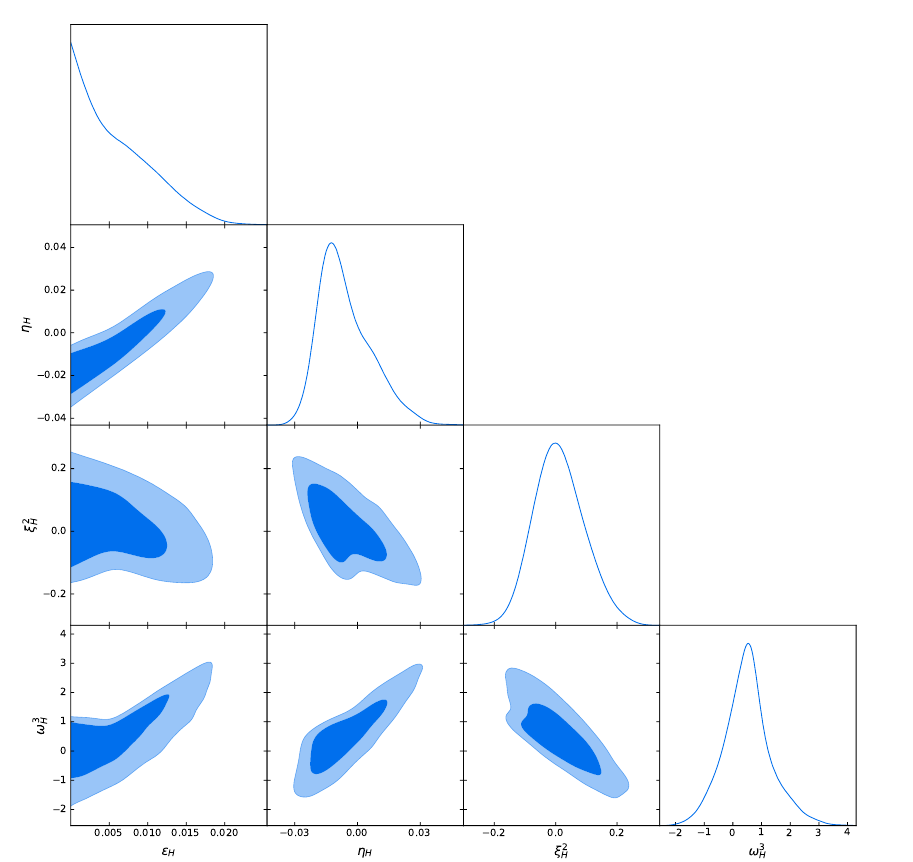
Figure 1: Marginalized joint distributions for parameter pairs at 68% and 95% confidence and marginalized distributions for individual parameters from the 5- dimensional likelihood of the slow-roll parameters in Eq.(14), also marginalized over the cosmological parameters in Eq.(15). We use the joint TT,TE,EE + lowE Planck data, these results should be compared with Fig. 13 of Ref. [ 12 ]